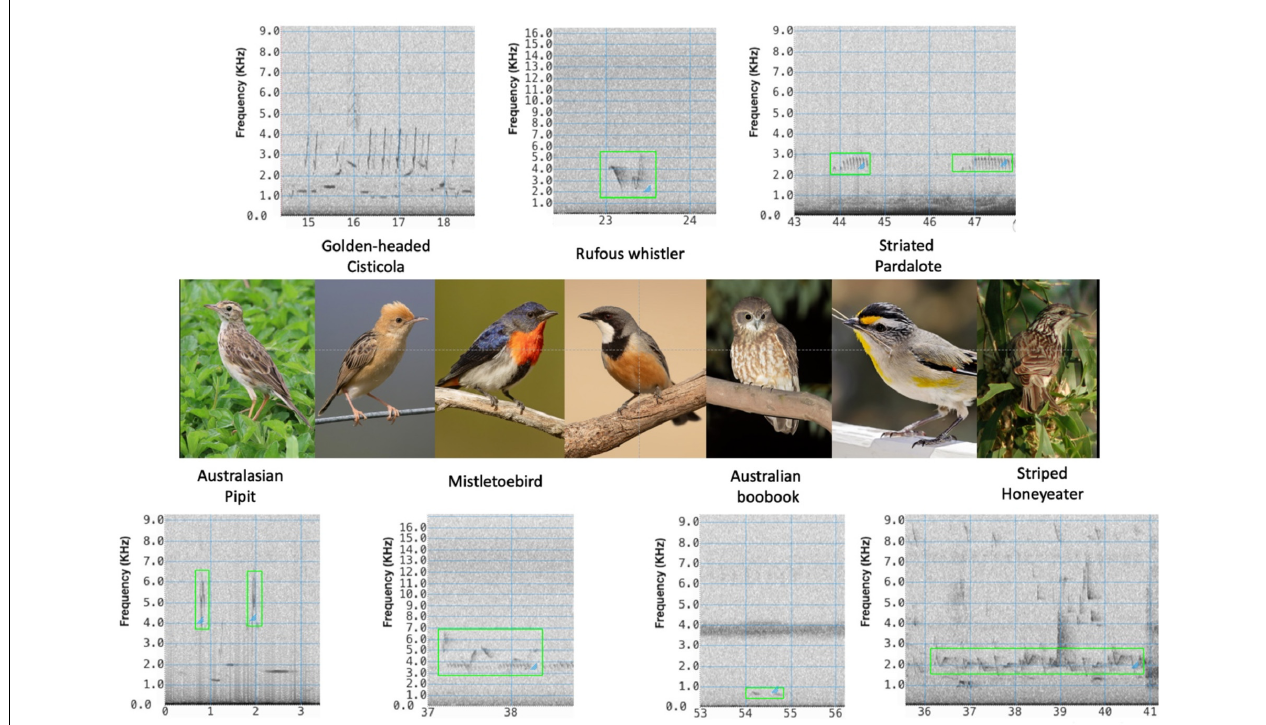
FIGURE 1 | Target species and their vocalizations. Australiasian Pipit, photo credit: https://commons.wikimedia.org/wiki/User:Summerdrought; https://creative commons.org/licenses/by-sa/4.0/; Golden-headed Cisticola, Mistletoebird, Rufous Whistler, Australian Boobook, photo credit: https://commons.wikimedia.org /wiki/User:JJ_Harrison; https://creativecommons.org/licenses/by-sa/4.0/legalcode. Striated Pardalote, photo credit: https://en.wikipedia.org/wiki/User:Fir0002; https://creativecommons.org/licenses/by-nc/3.0/legalcode. Striped Honeyeater, photo credit: https://commons.wikimedia.org/wiki/User:Aviceda; https://creative commons.org/licenses/by-sa/3.0/legalcode.